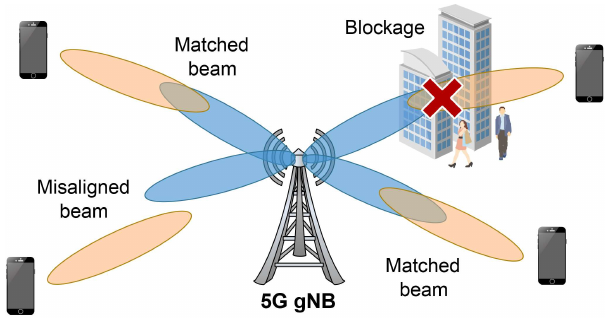
Figure 11. Beamforming scenarios in 5G mobile networks.